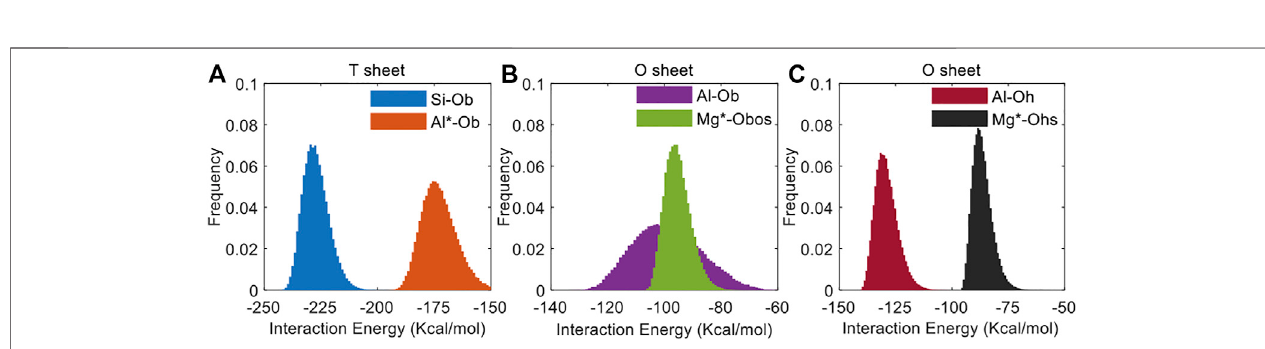
FIGURE4| Thefrequencyoftheinteraction energybetweenthe replaced atomorreplacementatomand the adjacent oxygen atominthe (A) Tsheet and (B,C) O sheet of the MMT layer before and after the isomorphous substitution.